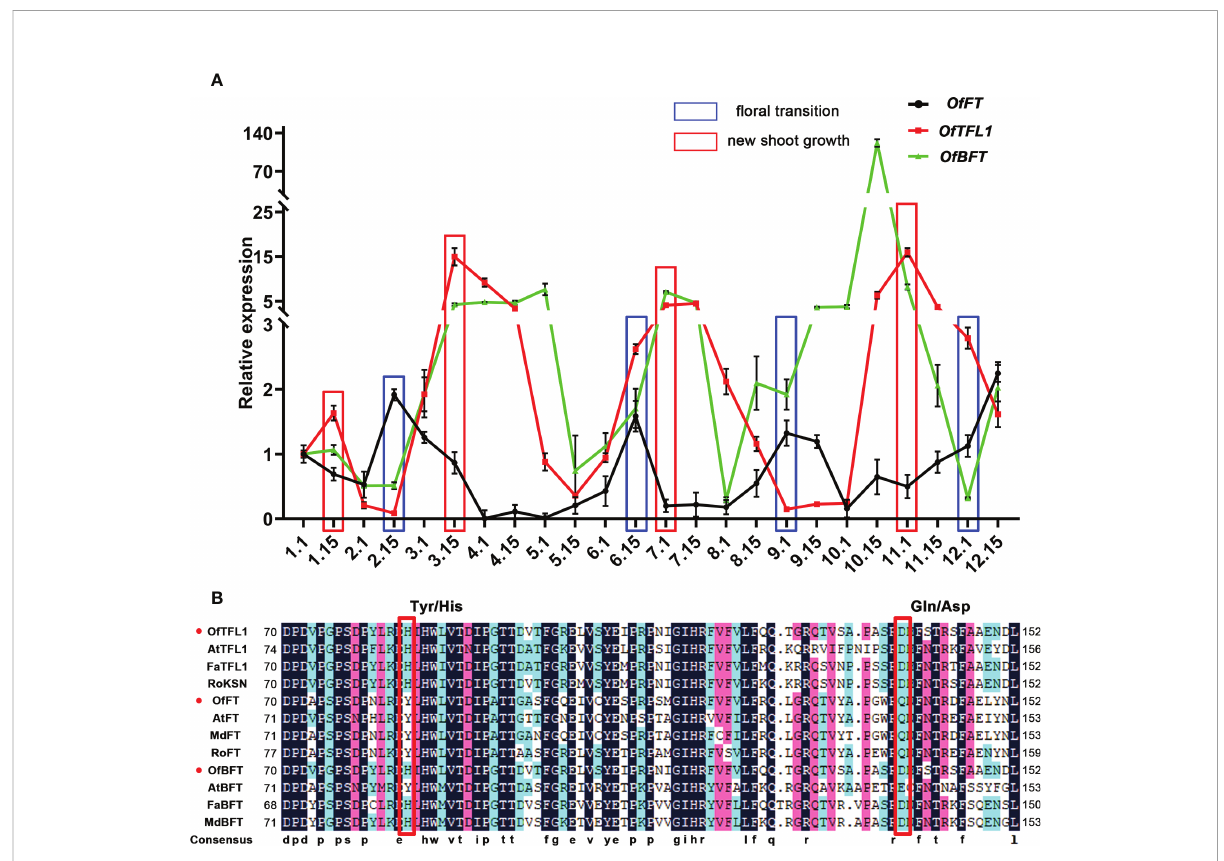
FIGURE 5 Isolation and expression analysis of OfFT , OfBFT , and OfTFL1 in OF and CF habits. (A) Expression patterns of OfFT , OfBFT , and OfTFL1 in 1 year. Red boxes represent the time new shoots occur. Blue boxes represent the time of fl oral transition. Means ±SD, n = 3. (B) Multiple amino acid sequence alignment of TFL1 and FT proteins in different species. Red box indicates Tyr/His and Gln/Asp that differed between TFL1 and FT